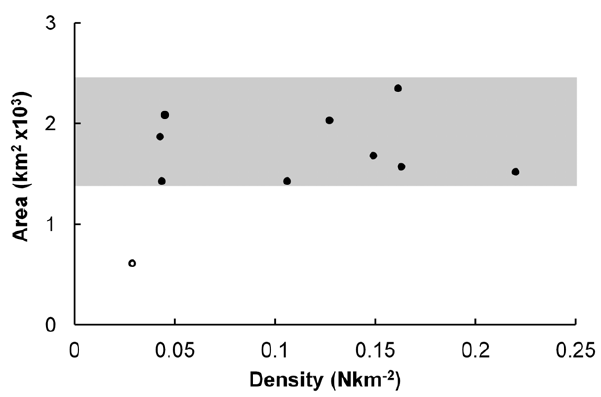
Figure 5. The relationship between density and occupancy of whales in Exmouth Gulf. The total area occupied was calculated as the convex hull area for each flight, and the density as number of whales per km 2 in this area. The pattern emerging is that of a constant area used with increasing density, as highlighted by the grey shaded area. One survey (flight 5), marked as an open circle, is an outlier to this pattern.